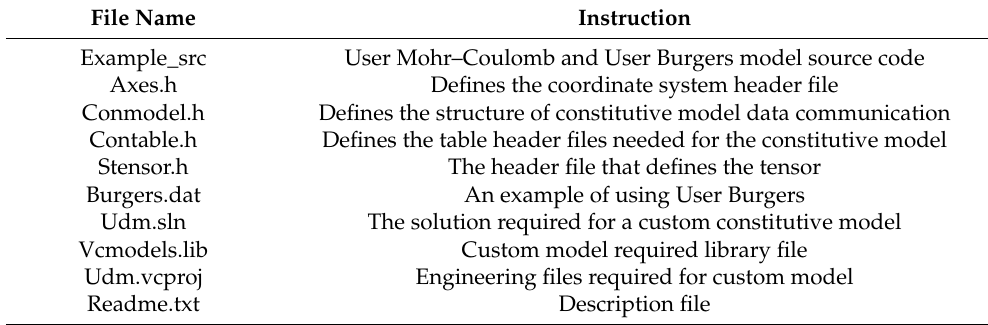
Table 2. UDM file description